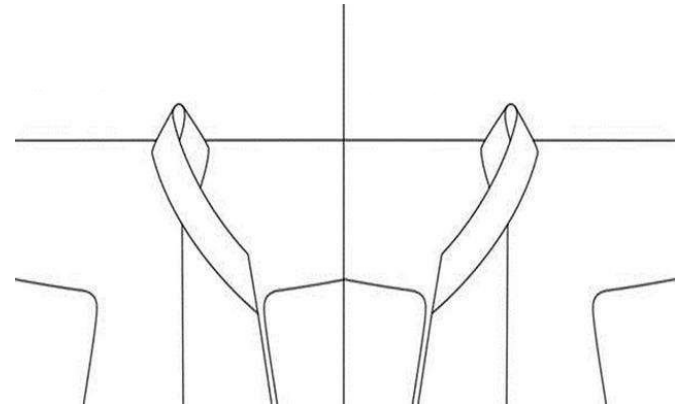
Figure 14. Left lapel and right lapel.